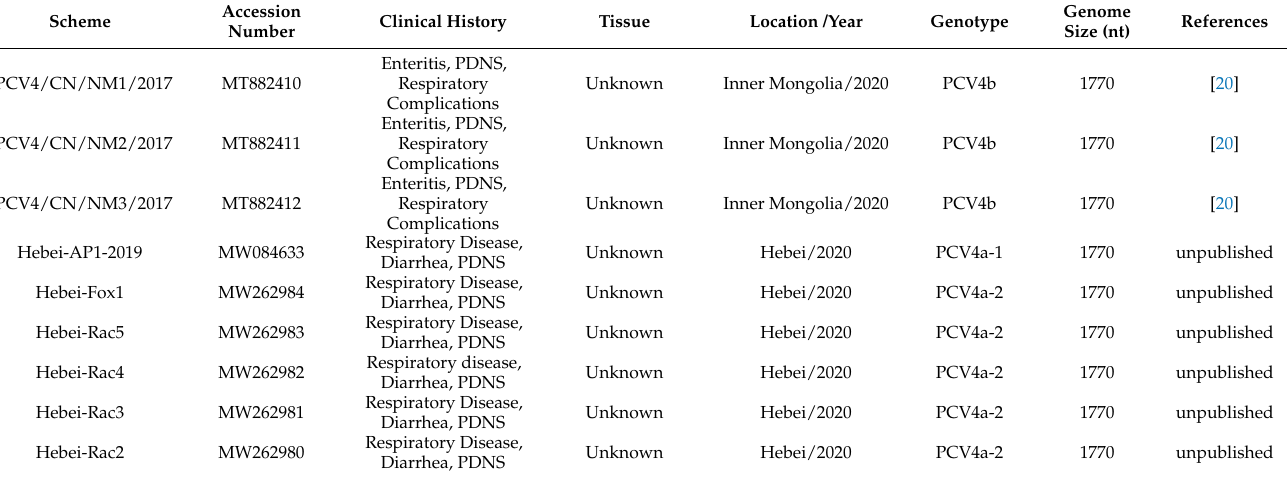
Table 1. The designations, clinical signs, genotypes, GenBank accession numbers and other character- istics of the PCV4 strains used in the present